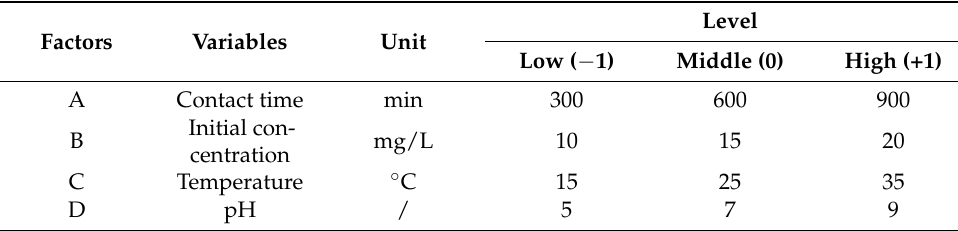
Table 2. Experimental ranges and levels of variables.